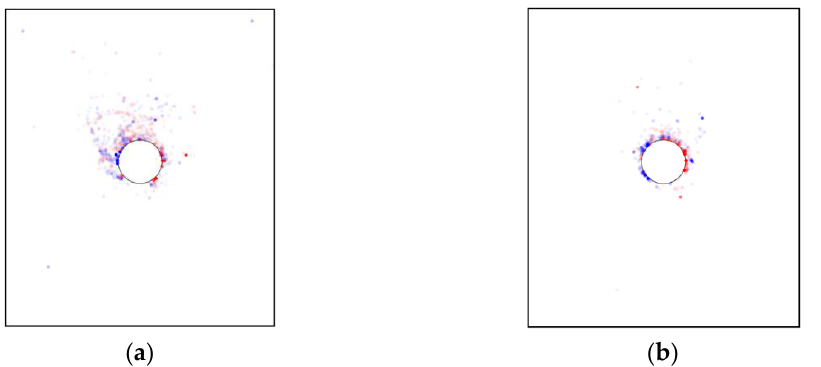
Figure 21. Particle rotation after the tunnel excavation in the cases of ( a ) AR4C3 and ( b ) AR6C3. Refer to Figure 12 for the legend.